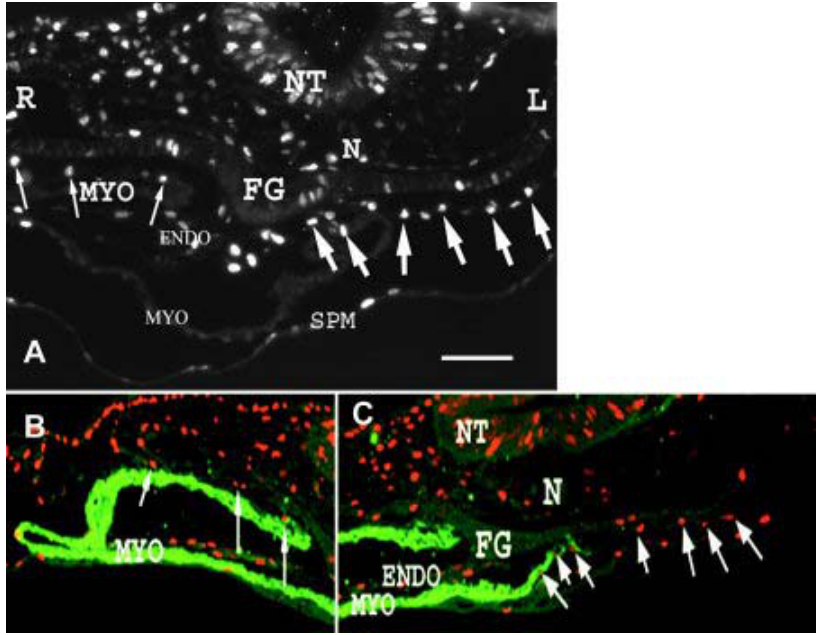
FIGURE 1. Asymmetric cell proliferation is evident in the dorsal mesocardial (DM) folds that are emerging from the anterior heart field. BrdU-labeling (arrows) shows that more cells are undergoing mitosis in the left DM fold (larger arrows) than in the right (smaller arrows) to initiate rightward directionality of looping between 7–9 somite stages. Reproduced with permission from Linask et